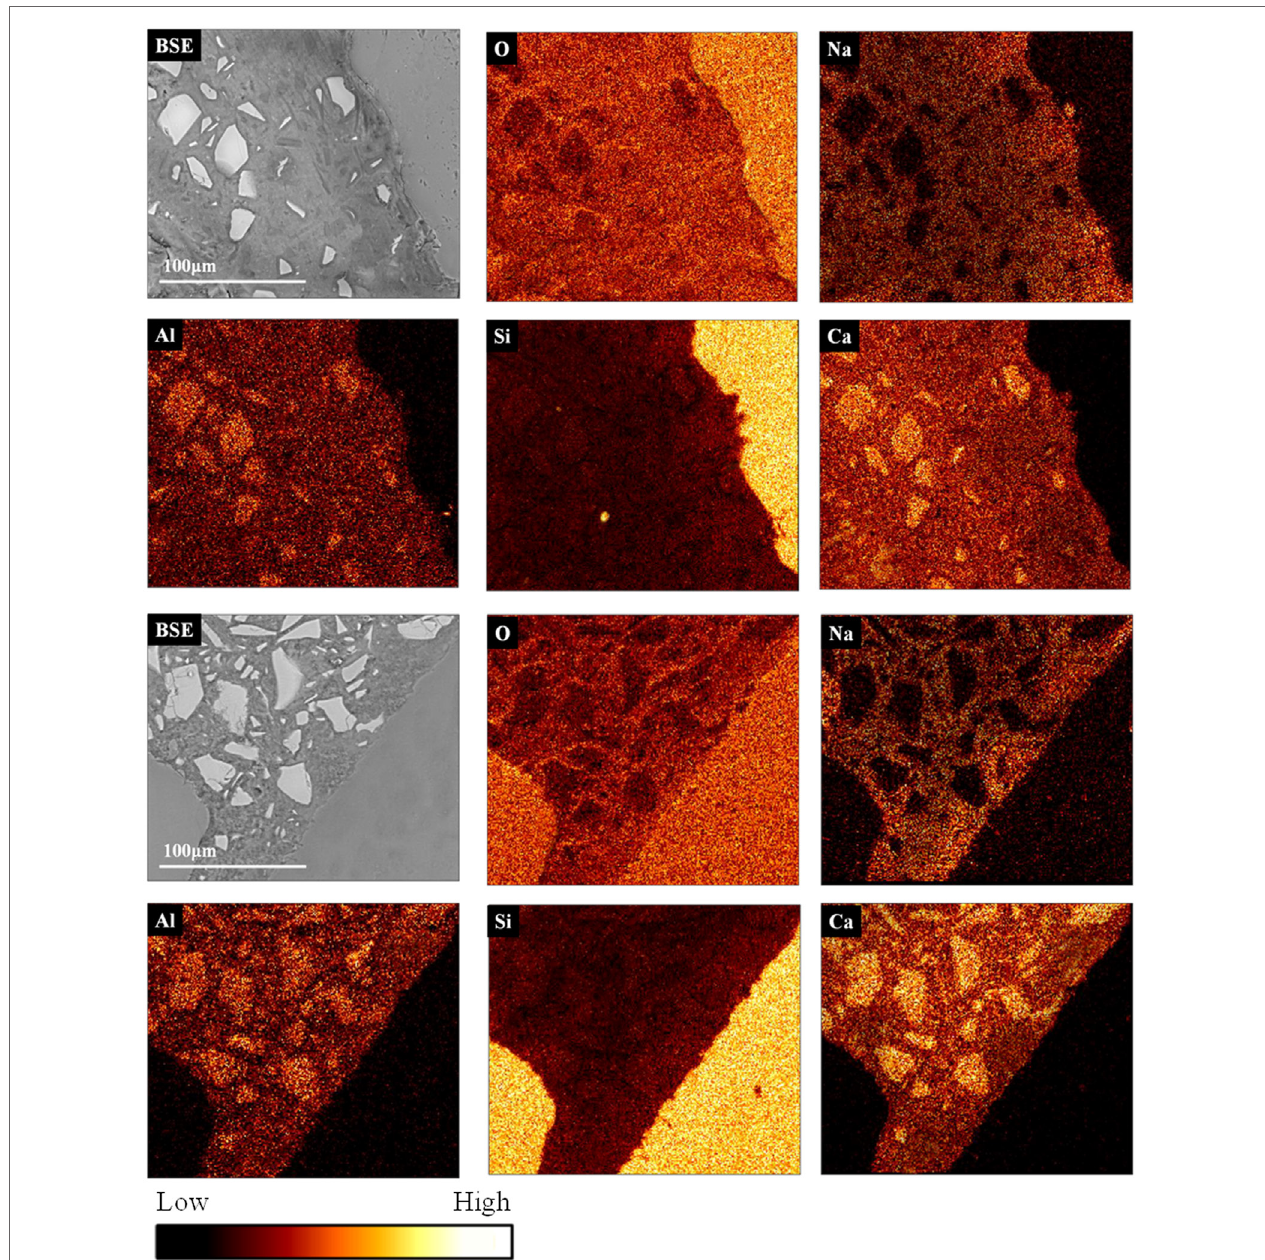
FigUre 5 | Backscattered electron images (Bse) and elemental maps (oxygen, sodium, aluminum, silicon, and calcium) for (top) high-alkali aas formulation, (bottom) low-alkali aas formulation and with medium sized sand aggregate, the color scale is comparative